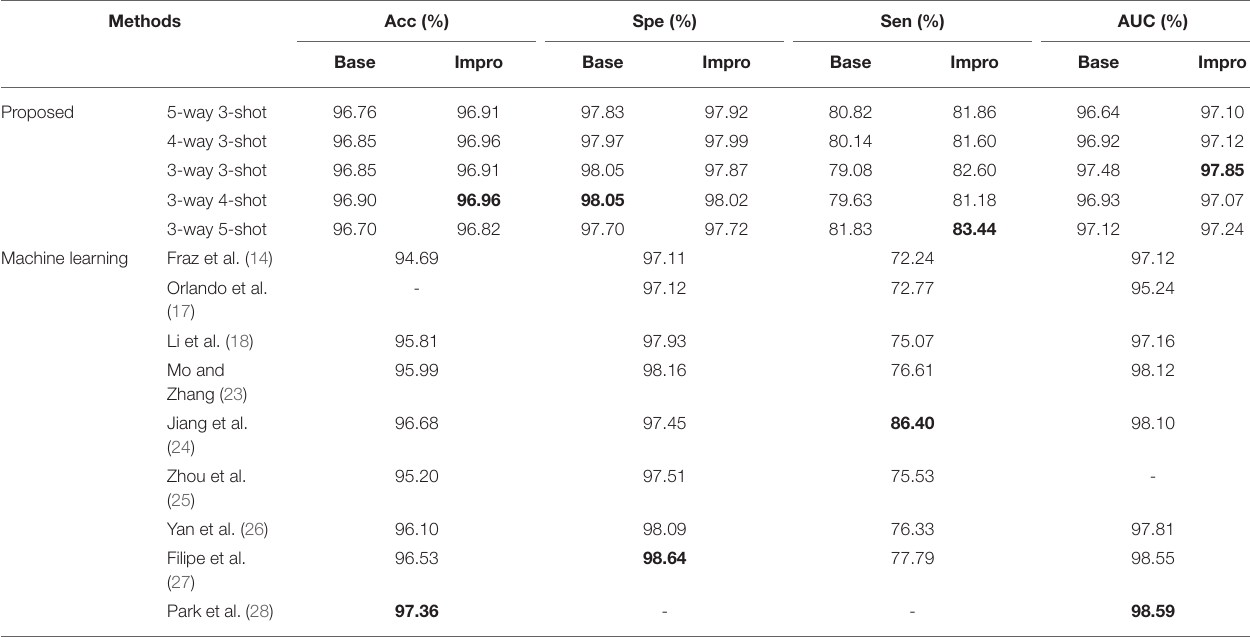
The bold values indicate the maximum value of the corresponding metric in the manuscript.